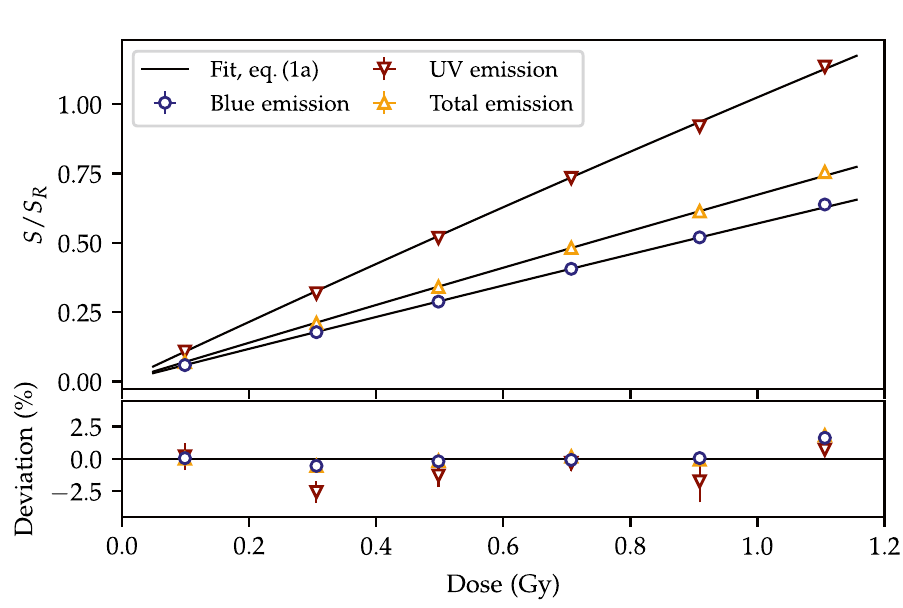
Figure 3. The 230 MeV dose calibration fitted with the saturating exponential in Eq. (1a) for the emission in the blue and the UV emission bands as well as the sum of the two during stimulation (denoted total